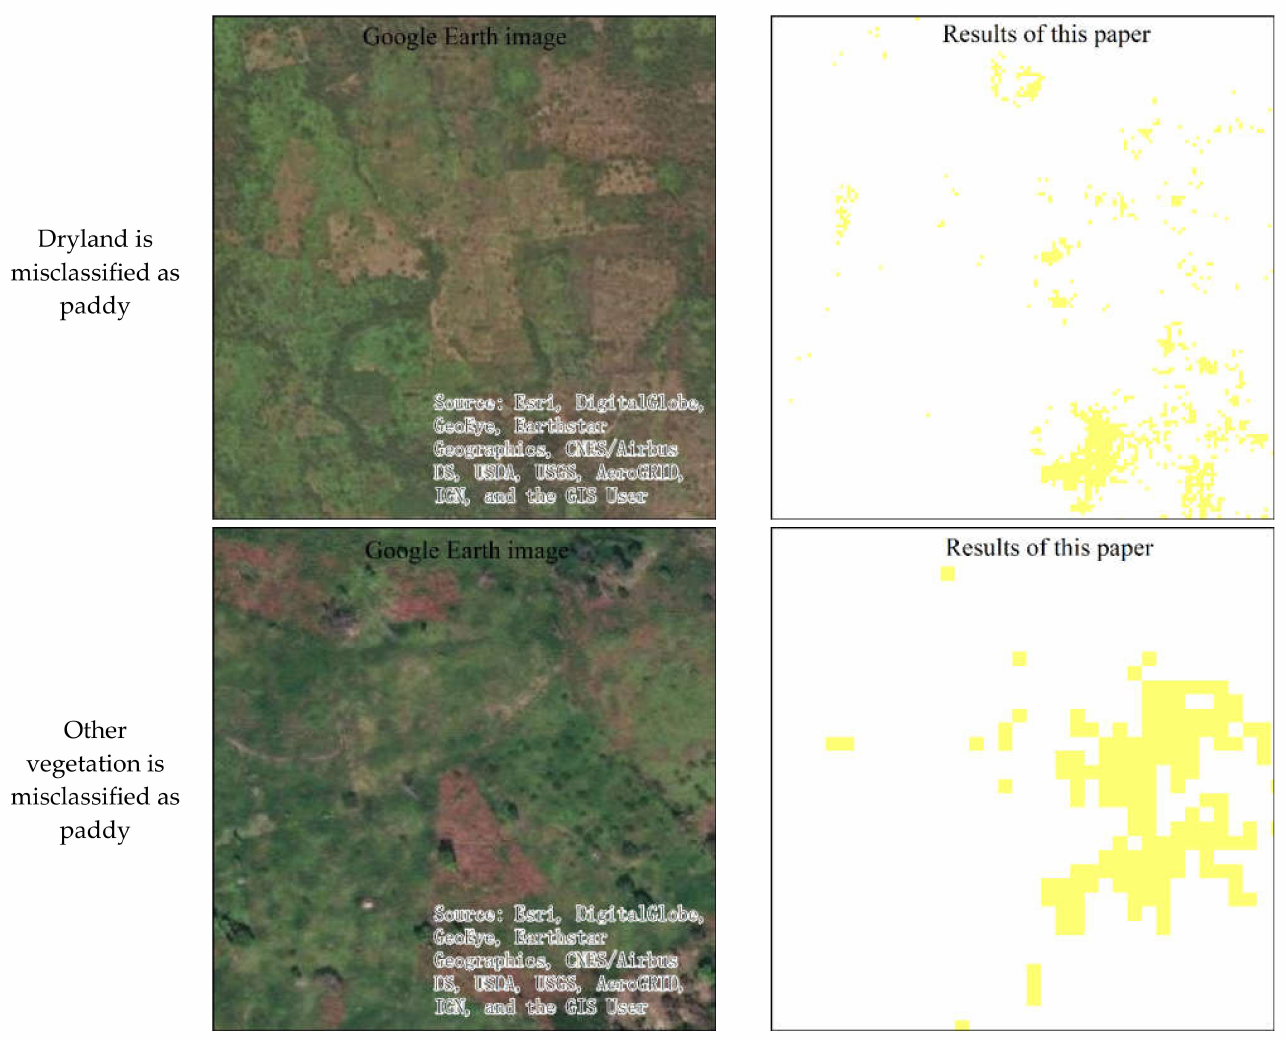
Figure 15. Examples of paddy